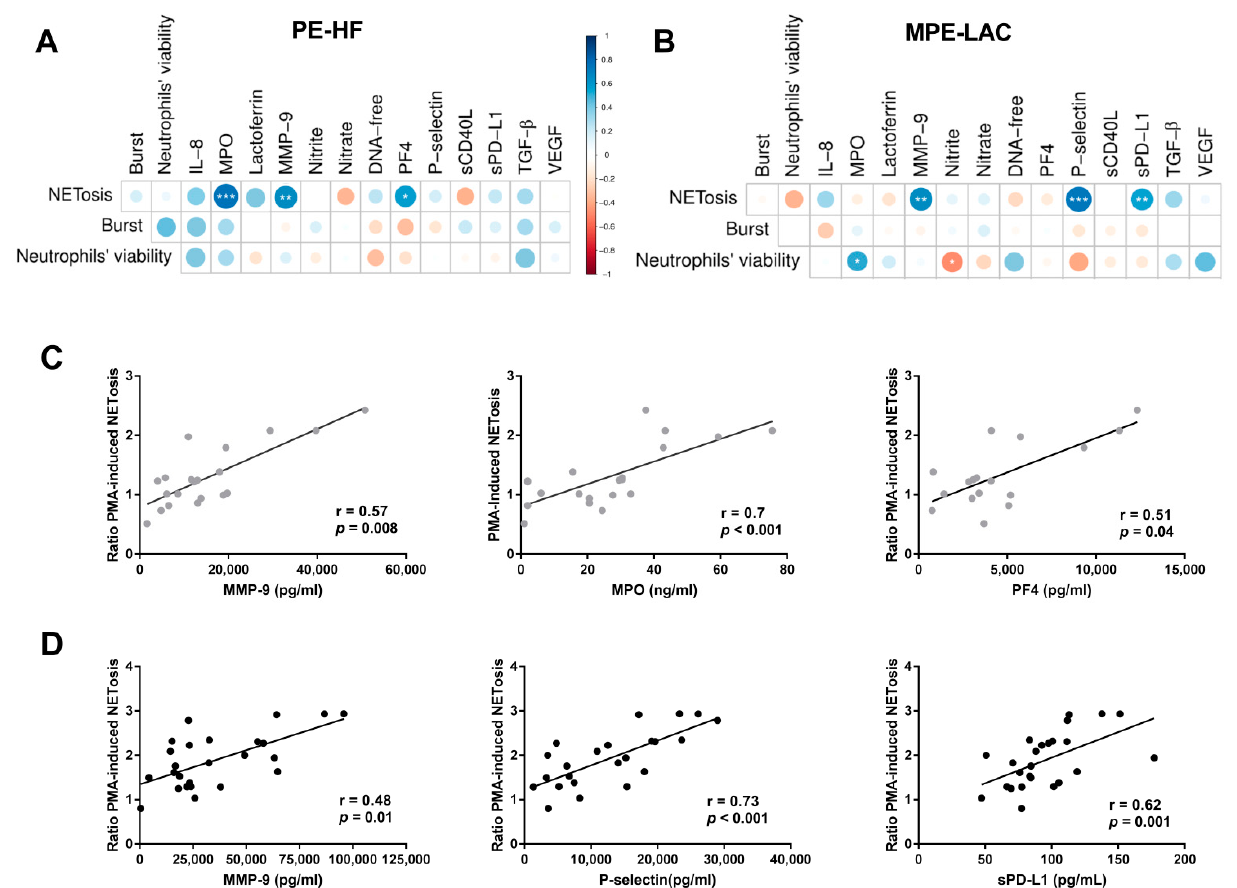
Figure 3. Correlation matrixes between neutrophil functions and platelet and neutrophil-derived factors in cf-PFs. Correlation matrices showing the association between neutrophil- and platelet- derived factors and neutrophils functions in ( A ) PE-HF and ( B ) MPE-LAC. The strength and direction of the correlations are indicated by the circle size and color. The statistical significance was represented by (*) p < 0.05, (**) p < 0.01, and (***) p < 0.001. Spearman correlations were established ( C ) between NETosis and the levels of MPO, MMP-9, and PF4 in cf-PE-HF and ( D ) between NETosis and the levels of lactoferrin and sPD-L1 in cf-MPE-LAC. The Pearson correlation was used for the correlation between NETosis and P-selectin.